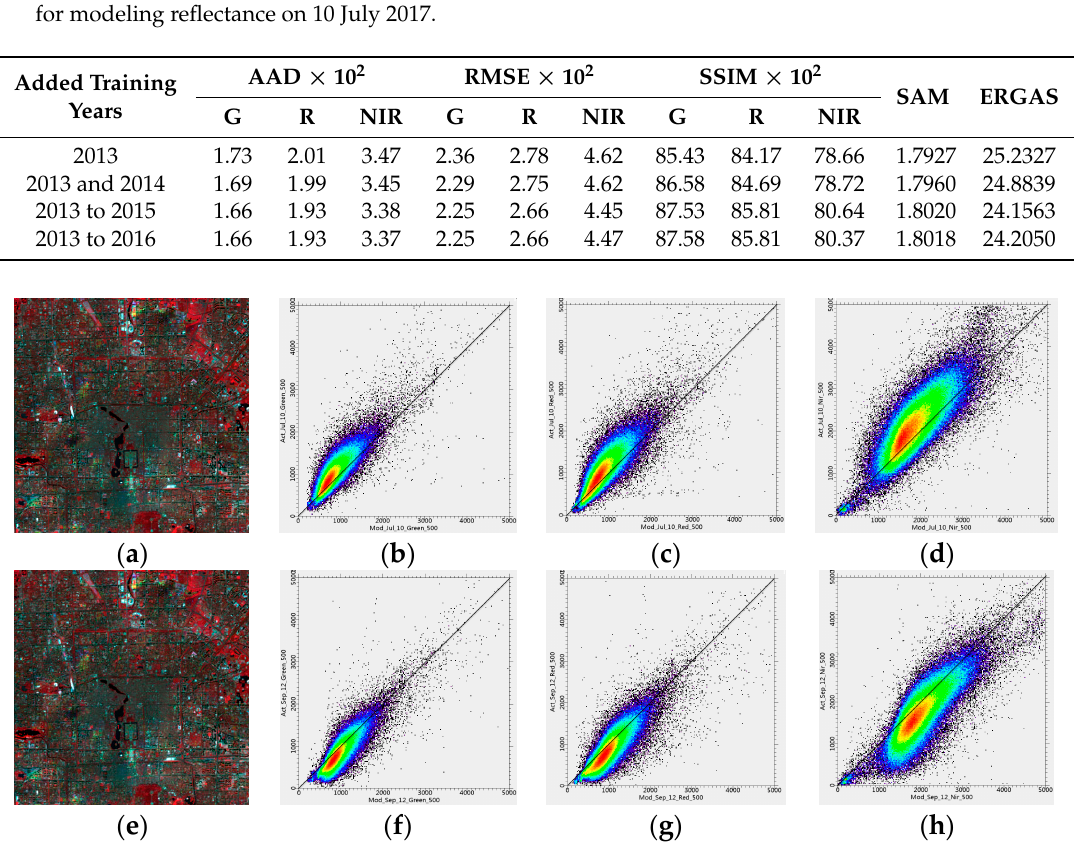
Figure 10. Proposed bi-directional fusion results with temporally extended training samples (from 2013 to 2016) using the urban dataset: ( a ‒ d ) the composited fusion results of modeled reflectance on 10 July 2017 and the comparison with actual reflectance; ( e ‒ h ) the composited fusion results of modeled reflectance on 12 September 2017 and the comparison with actual reflectance. Table 9. Assessment indices from the proposed fusion with the urban data acquired from 2013 to 2016 for modeling reflectance on 10 July 2017.